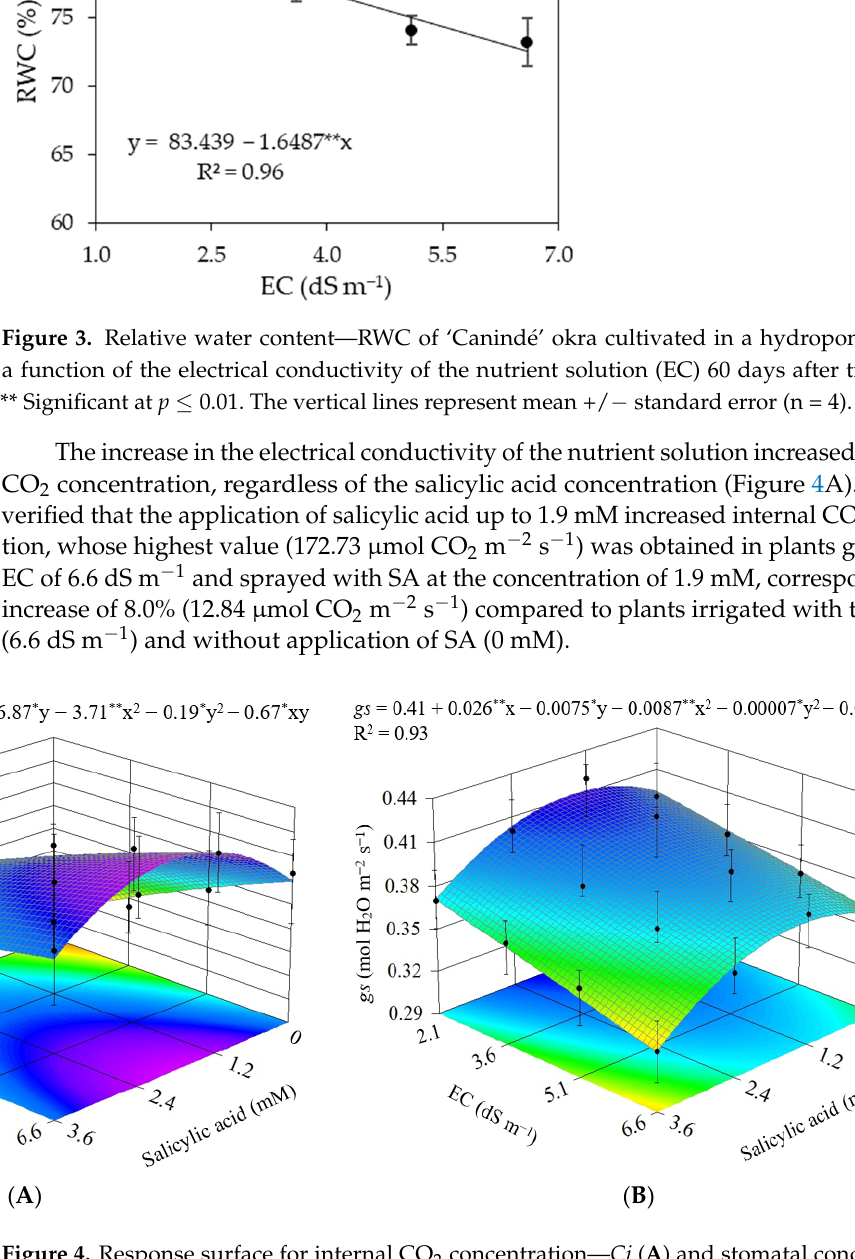
Figure 4. Response surface for internal CO 2 concentration— Ci ( A ) and stomatal conductance— gs ( B ) of ‘Canindé’ okra cultivated in a hydroponic system as a function of the interaction between the electrical conductivity of the nutrient solution (EC) and the concentrations of salicylic acid, 60 days after transplanting. X and Y—concentration of salicylic acid and EC, respectively; * and ** Significant at p ≤ 0.05 and ≤ 0.01, respectively. The vertical lines represent mean +/ − standard error (n = 4).